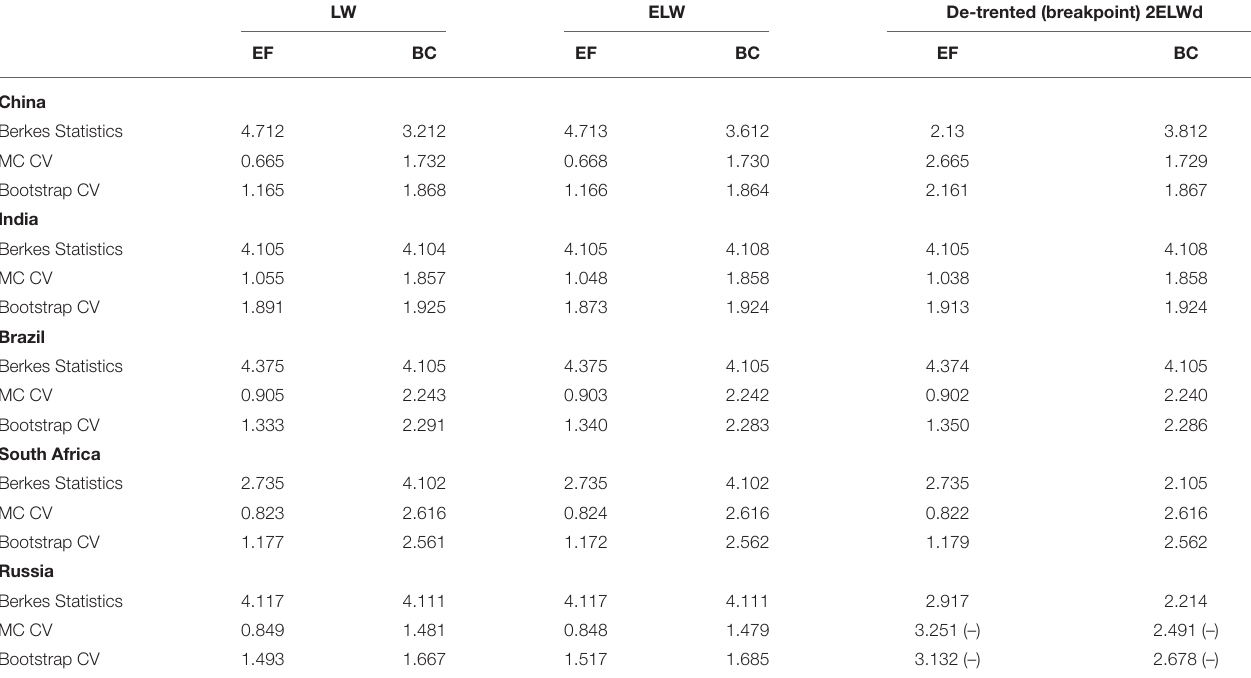
TABLE 5 | Pseudo long memory Berkes test of relative per capita environmental indicators in BRICS. LW ELW De-trented (breakpoint) 2ELWd EF